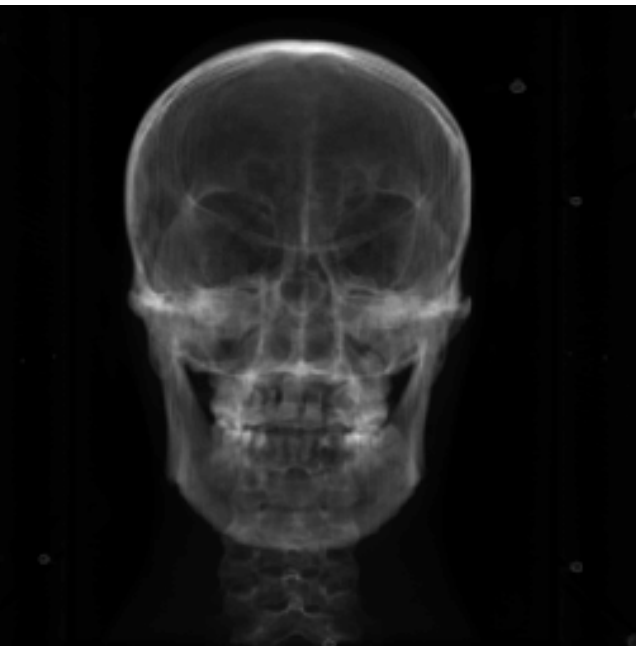
Figure 5. DRR image at the initial value.